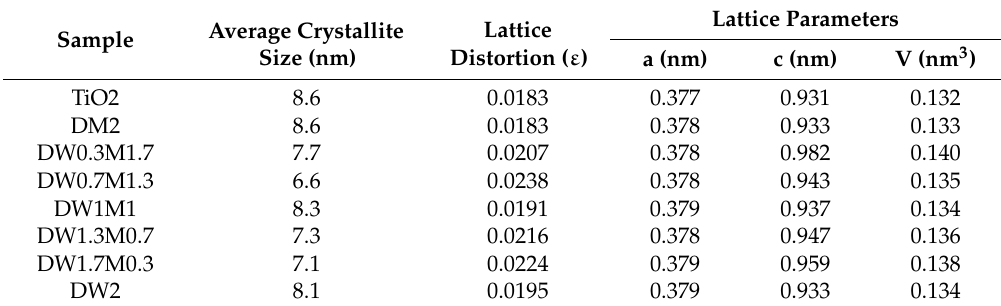
Figure 3. X-ray diffraction patterns of all prepared catalysts. Table 1. Crystal size, lattice distortion and lattice parameters of the synthesized materials.